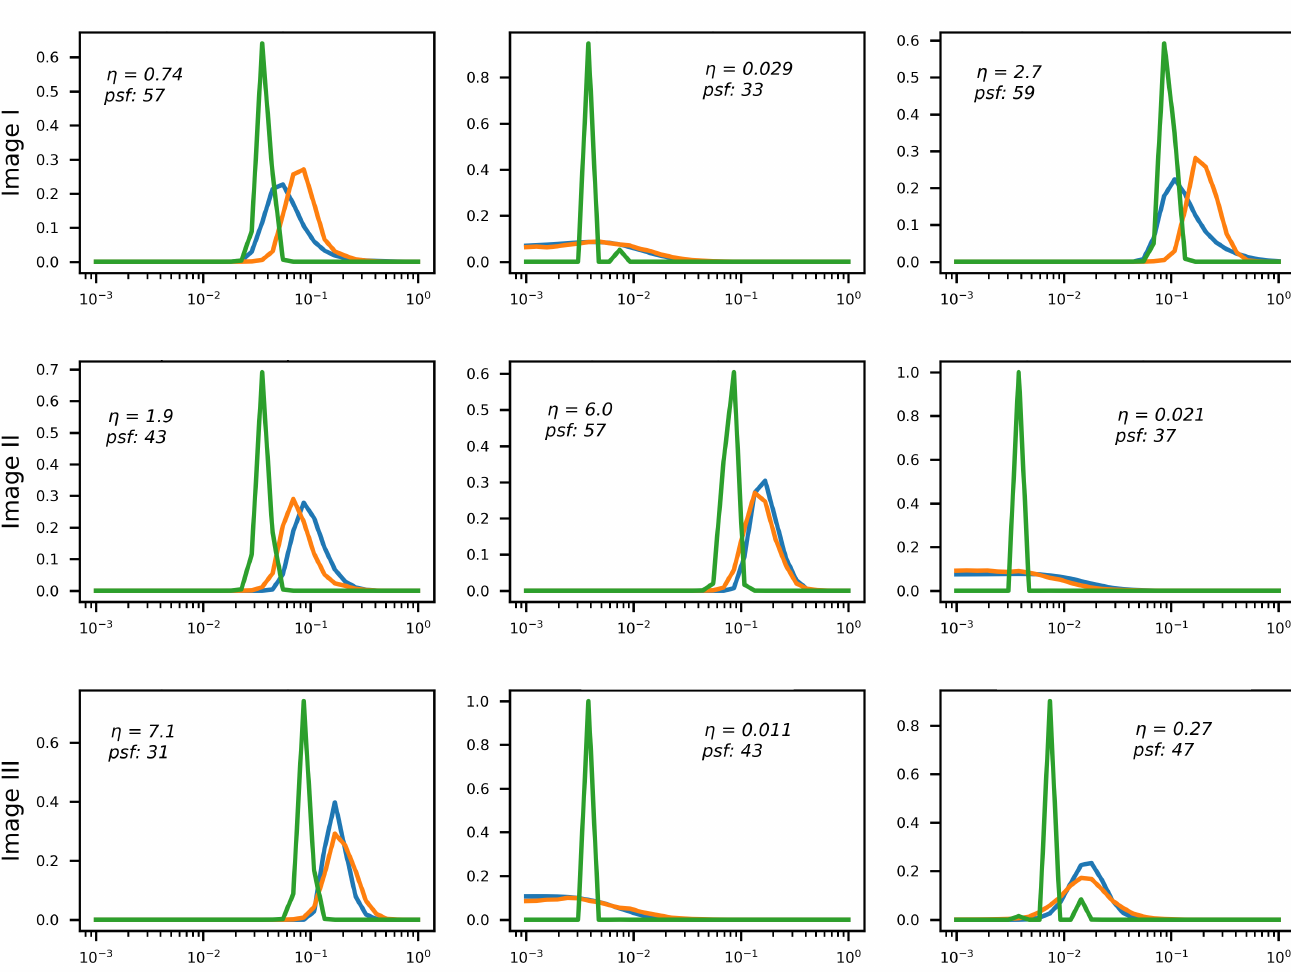
Figure 15. Effect of E2E training on λ -weight array generation; Blue line: reference g ( λ ) , Orange: standalone f ( λ ) , Green: f ( λ ) after E2E